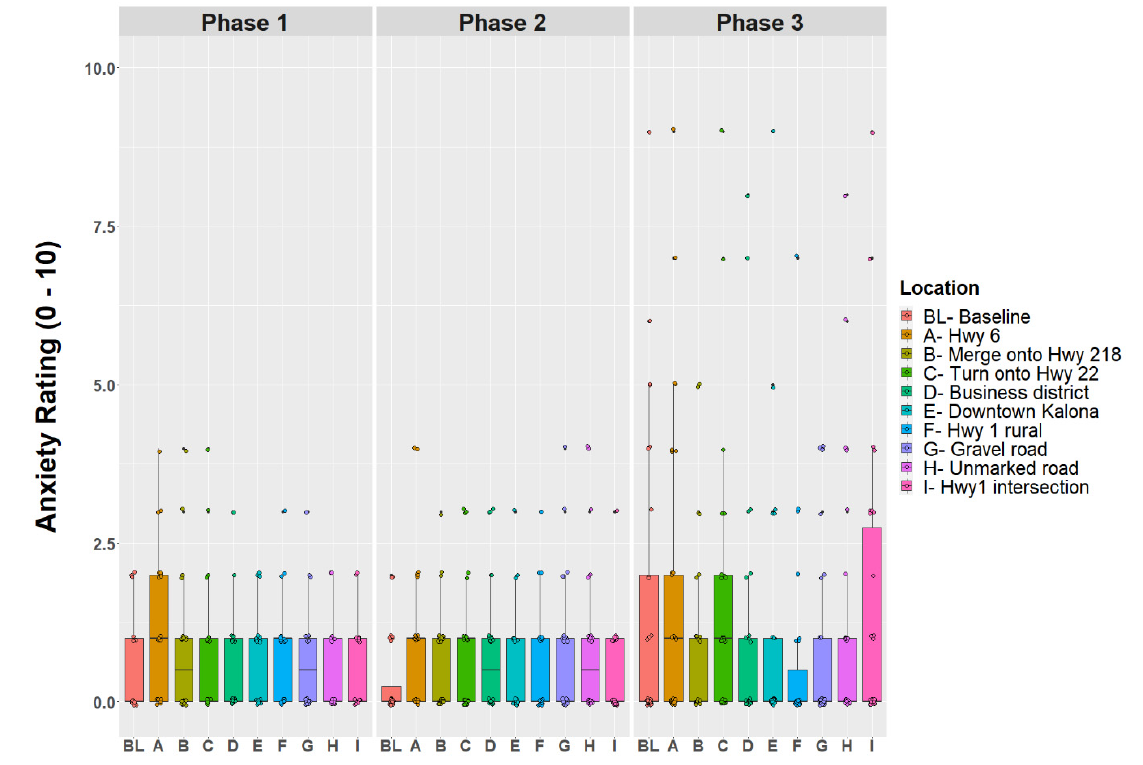
Figure 5. Boxplot with jitter displaying anxiety ratings by location and between the phases.